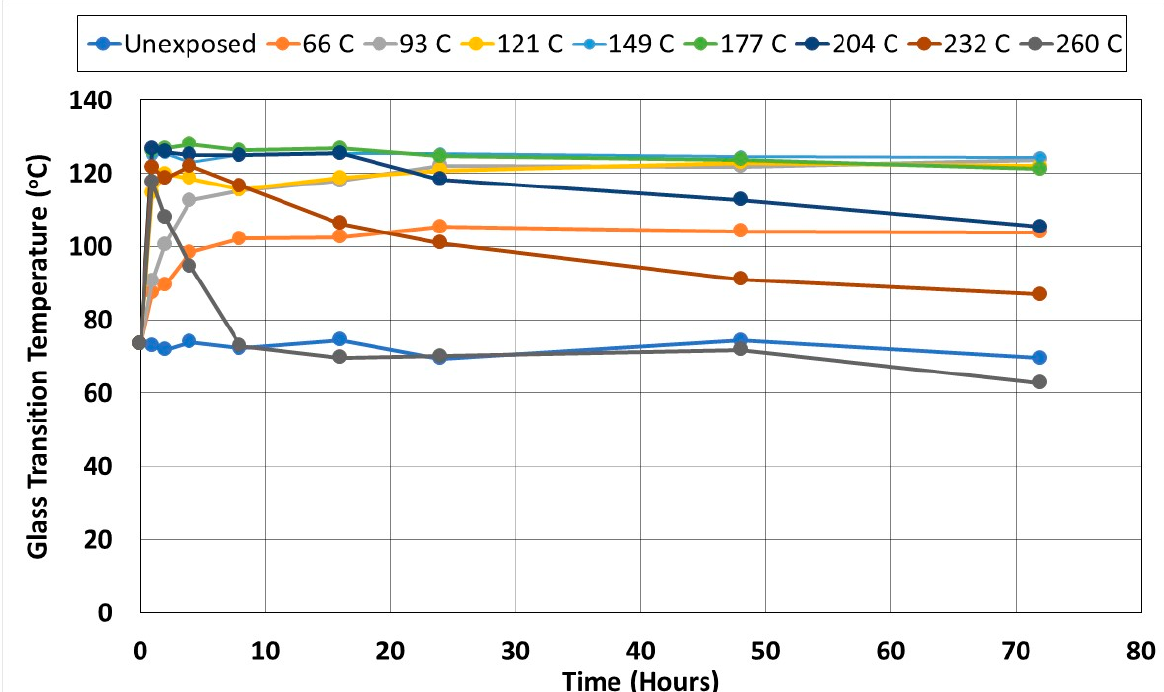
Figure 10. Change in DSC derived glass transition temperature as a function of exposure temperature and time.